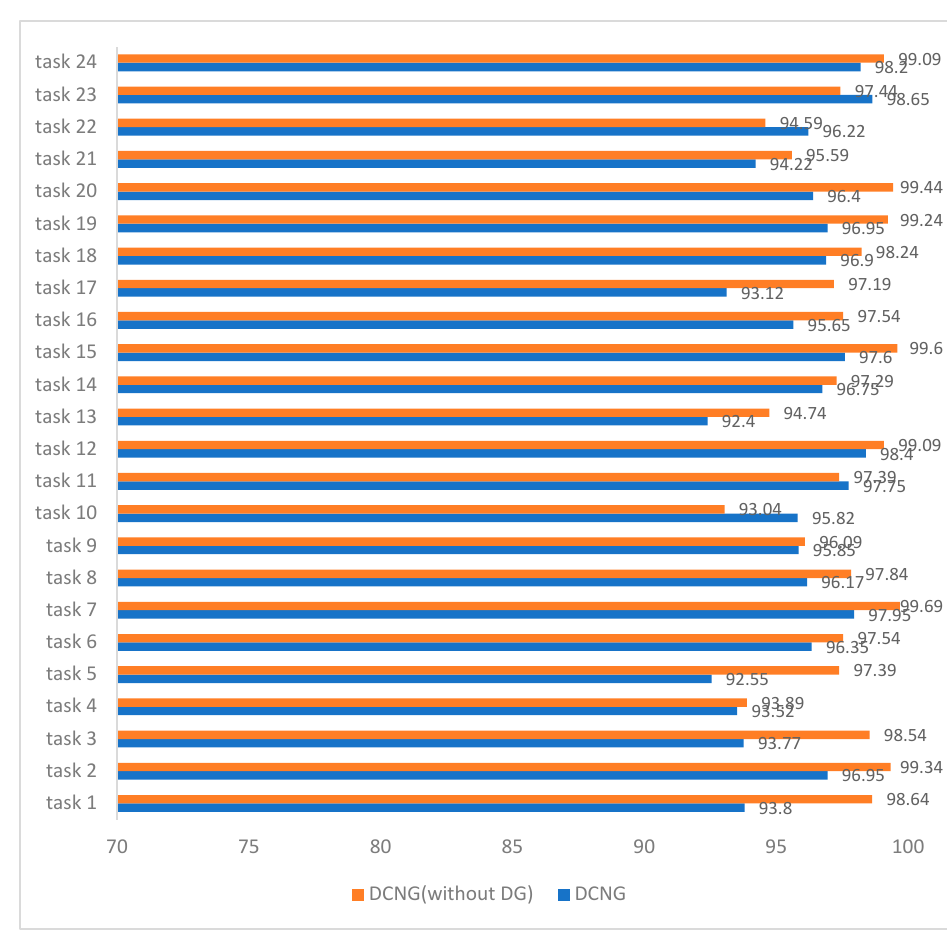
Table 8. Performance of ungeneralized model DCNG on MFPT dataset.